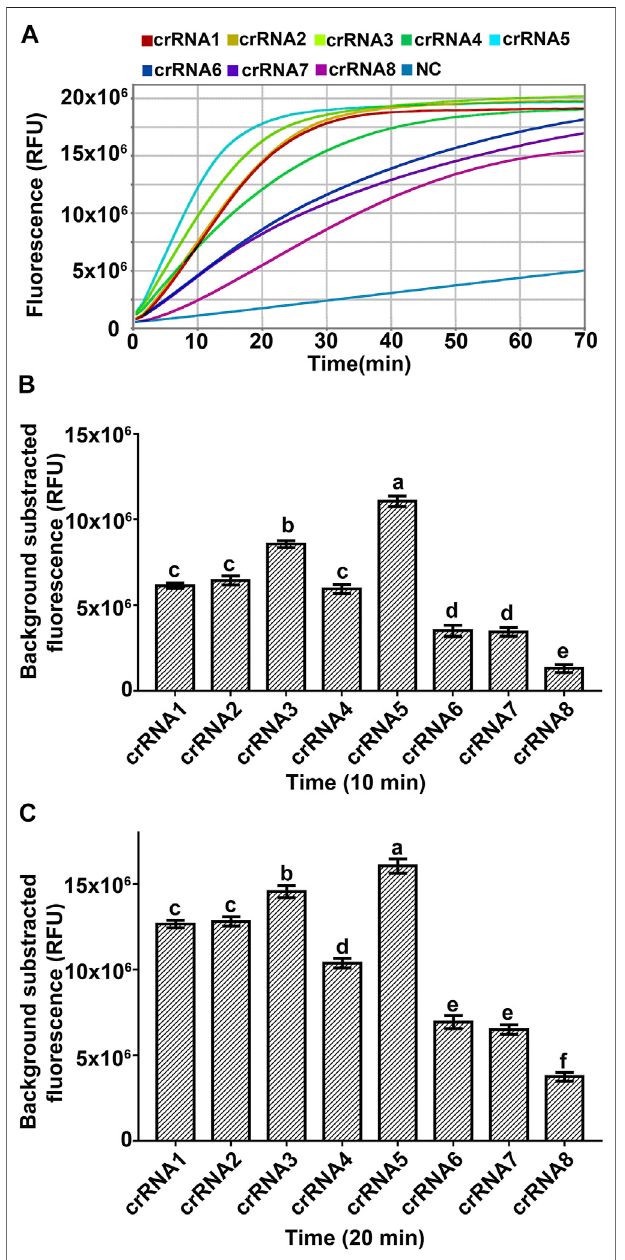
FIGURE3| ScreeninganoptimalcrRNAforRPA-Cas12a-Abassaywith FQ-reporter. (A) Representative fl uorescencekineticsofdifferentcrRNAusing the Real-Time PCR system (Applied Biosystems, QuantStudio 6 Flex). NC, no crRNA control. (B) Fluorescence signals obtained at 10 min Cas12a reaction of different crRNA. (C) Fluorescence signals obtained at 20 min Cas12areactionofdifferentcrRNA.Thedataarepresentedasmean±SD( n = 3). crRNAs that are signi fi cantly different from each other are labeled with different lowercase letters above each bar.